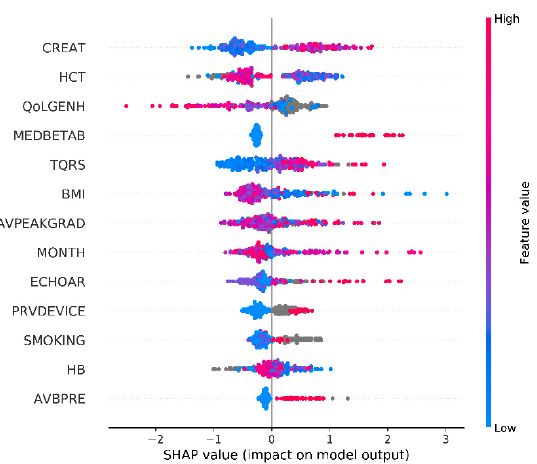
Figure 4. SHapley Additive exPlanations summary plot (missing values are shown in grey).